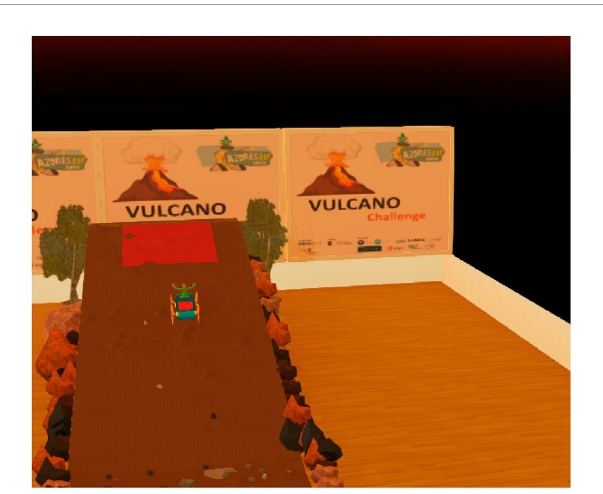
FIGURE 11 Simulated Vulcano world with the Vulcano robot picture on the